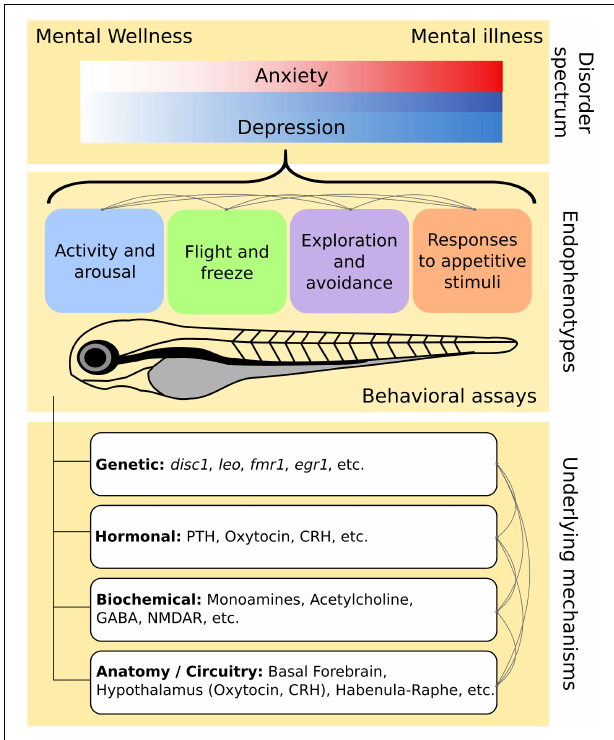
FIGURE 1 | Conceptual relationship between endophenotypes and disease spectrum. Depression and anxiety exists along a spectrum of mental wellness to illness. There are overlapping and distinct aspects of these disorders that are also reflected in their shared and individual endophenotypes. Although we have categorized the endophenotypes into four main groups, these endophenotypes are interconnected and their relationships are worth investigating. The endophenotypes are supported by various underlying mechanisms, many of which are also interconnected. Multiple mechanisms may govern a single endophenotype while likewise, many endophenotypes can share similar